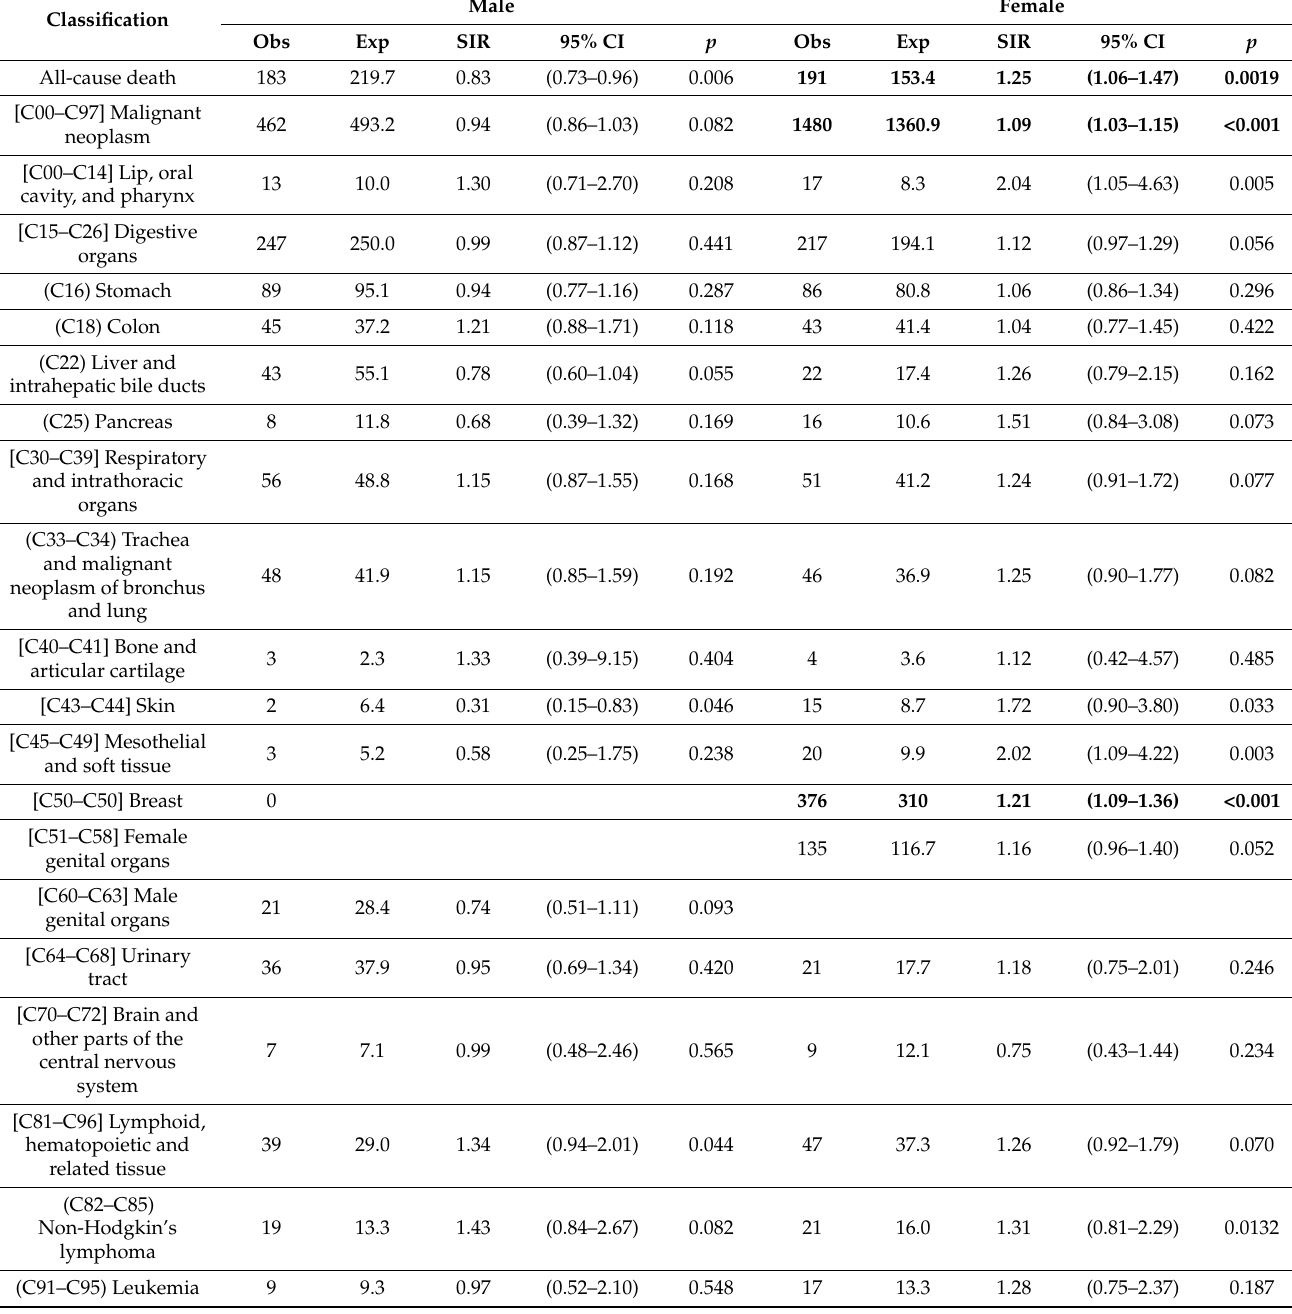
Table 2. The observed number of deaths, standardized incidence ratios, and 95% intervals, with total workers as the reference